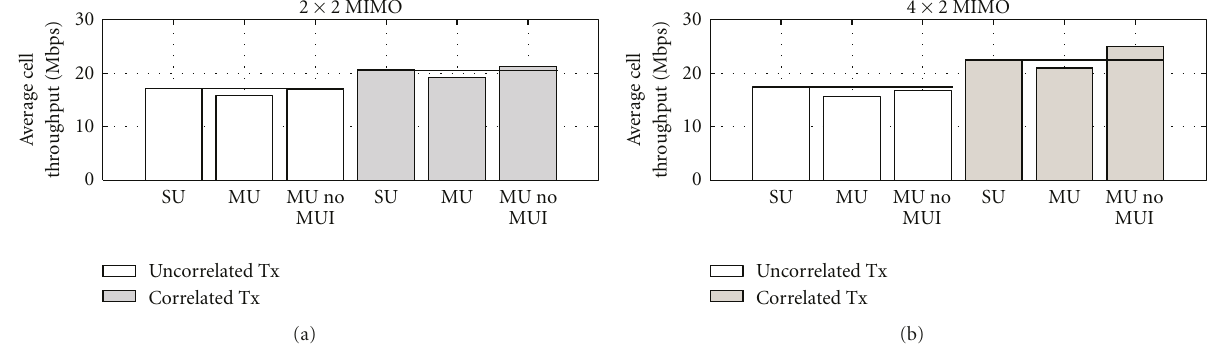
Figure 8: The average cell throughputs for 2 × 2 MIMO and 4 × 2 MIMO settings.